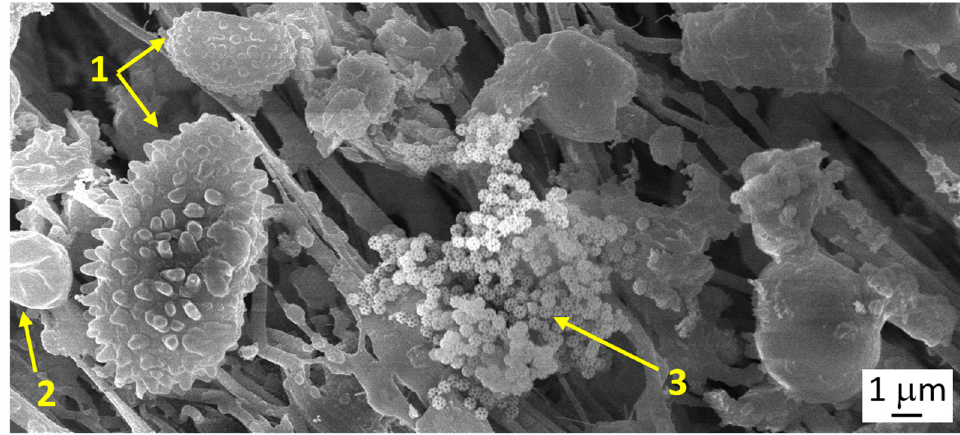
Figure 8. Comparison of shapes and sizes of different types of PBA: ( 1 )—spores of fungi, ( 2 )—pollen grain, ( 3 )—agglomerate of brochosomes.